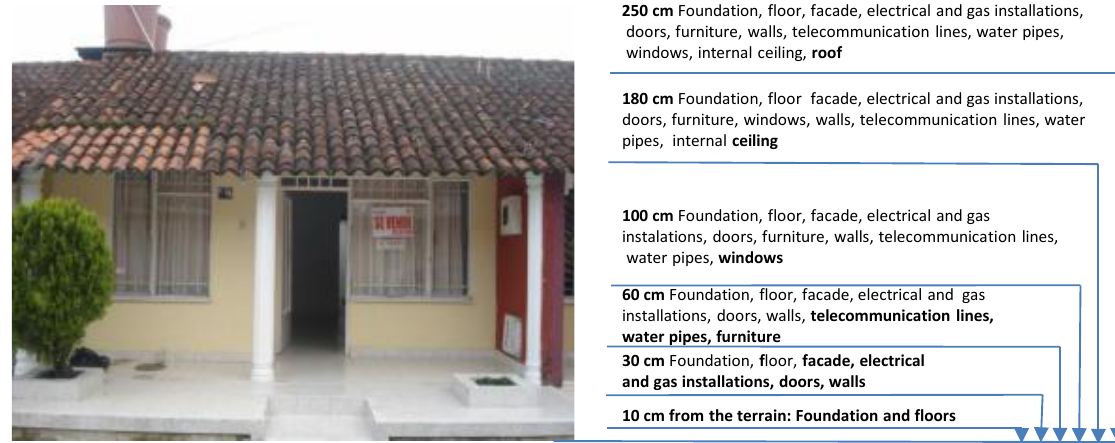
Figure 2. Relevant components of the building exposed to water